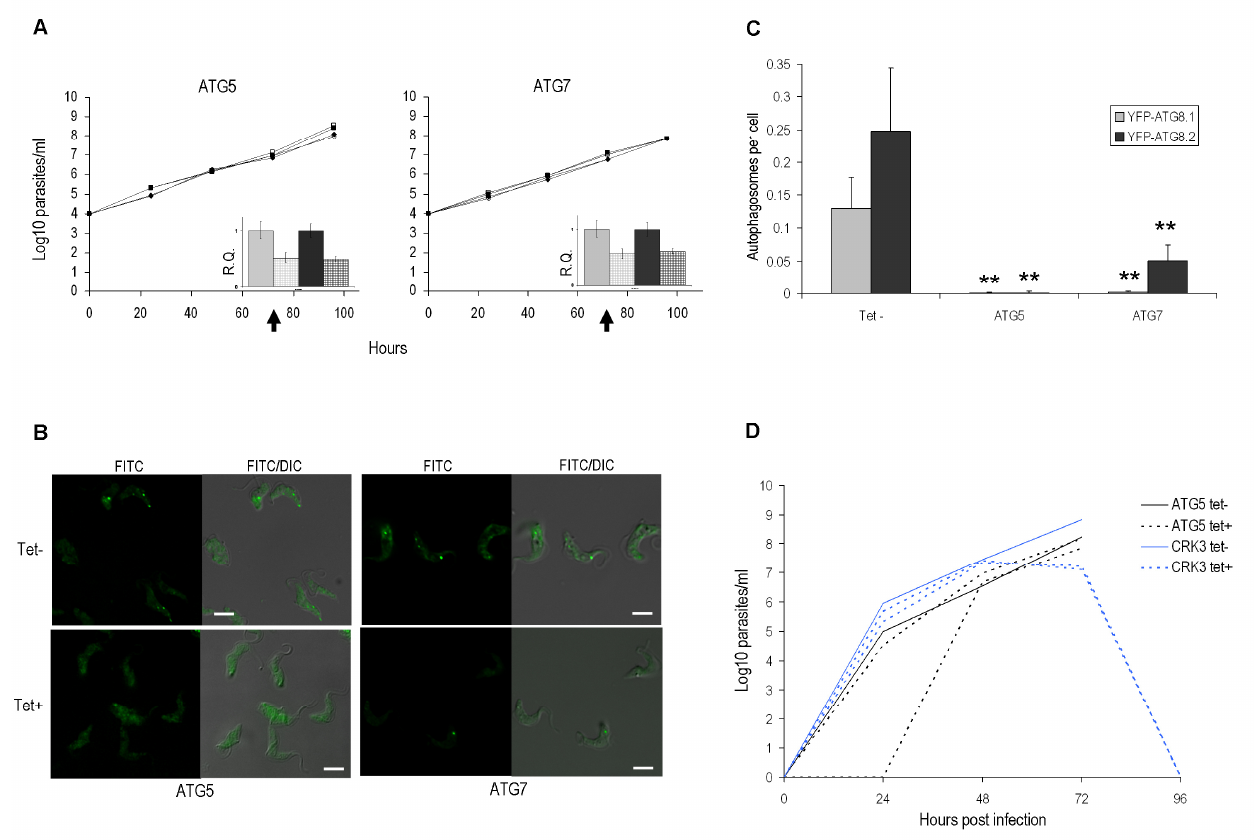
FIGURE 3: RNAi of autophagy genes in bloodstream form. (A) Growth analysis of BSF RNAi mutants in vitro . RNAi of ATG5 and ATG7 genes in BSF 2T1 constitutively expressing YFP-ATG8.1 (diamonds) and YFP-ATG8.2 (squares). RNAi induced with tetracycline (filled symbols) and growth compared to controls (empty symbols) for 96 h. Cells were reseeded to 1 x 10 4 ml -1 at 48 h as required, with cumulative values shown. Arrows indicate time point selected for microscopy analysis. Inset: qPCR of ATG5 or ATG7 cell lines 72 h after tetracycline induction (hatch) or control in BSF 2T1 clones expressing either YFP-ATG8.1 (grey) or YFP-ATG8.2 (black). Error bars represent one standard deviation derived from three replicates. (B) RNAi depletion of ATG genes influences autophagy. Constitutive expression of YFP-ATG8.1 and YFP-ATG8.2 in BSF 2T1 cells was visualised by fluorescent microscopy following individual RNAi of ATG5 and ATG7 . Left hand images FITC filter set, right hand images FITC DIC merge. Scale bar 5 µm. (C) The mean number of autophagosomes per cell was determined in ATG5 and ATG7 RNAi lines by counting >200 cells 72 h after induction, with data displayed as a mean of three replicate experiments. Error bars represent standard deviation and asterisks indicate where data differed significantly from the mean of the un-induced controls **p<0.01. (D) Growth analysis of BSF ATG5 and CRK3 RNAi mutants in vivo . 1 x 10 5 ( ATG5 ) and 5 x 10 5 ( CRK3 ) trypanosomes were inoculated in 3 mice and RNAi induced with doxycycline (Dox) in 2 mice 24 h ( ATG5 ) or 48 h ( CRK3 ) later. Parasitaemia was monitored by tail bleed and counting on a